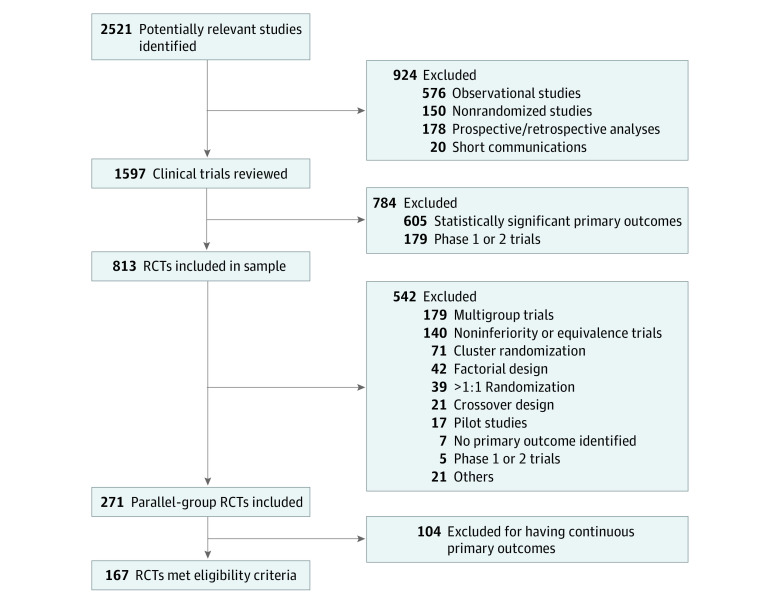
Flowchart of Search StrategyRCT indicates randomized clinical trial.